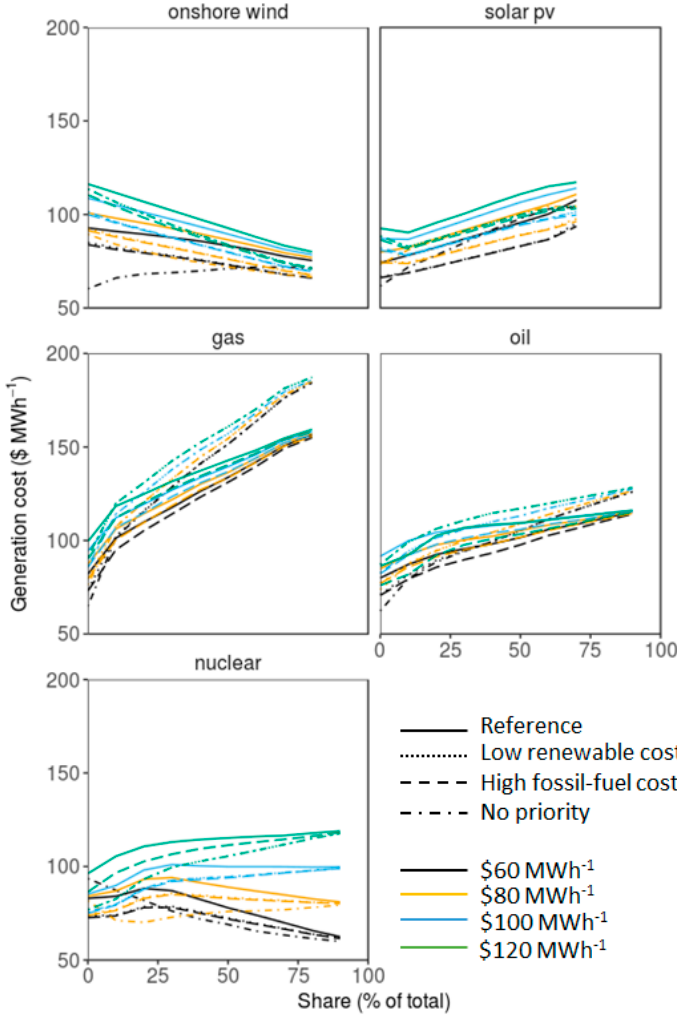
Figure 4. Tenerife example: the median value of each section of the generation costs of each source with respect to incremental changes in the average generation cost of nuclear power, from $60 to 120 MWh − 1 . Illustrated are four generation variations: (1) reference case, (2) low renewable cost, (3) low renewable and high fossil-fuel cost, (4) no dispatch priority to renewables on the low renewable and high fossil-fuel cost case.